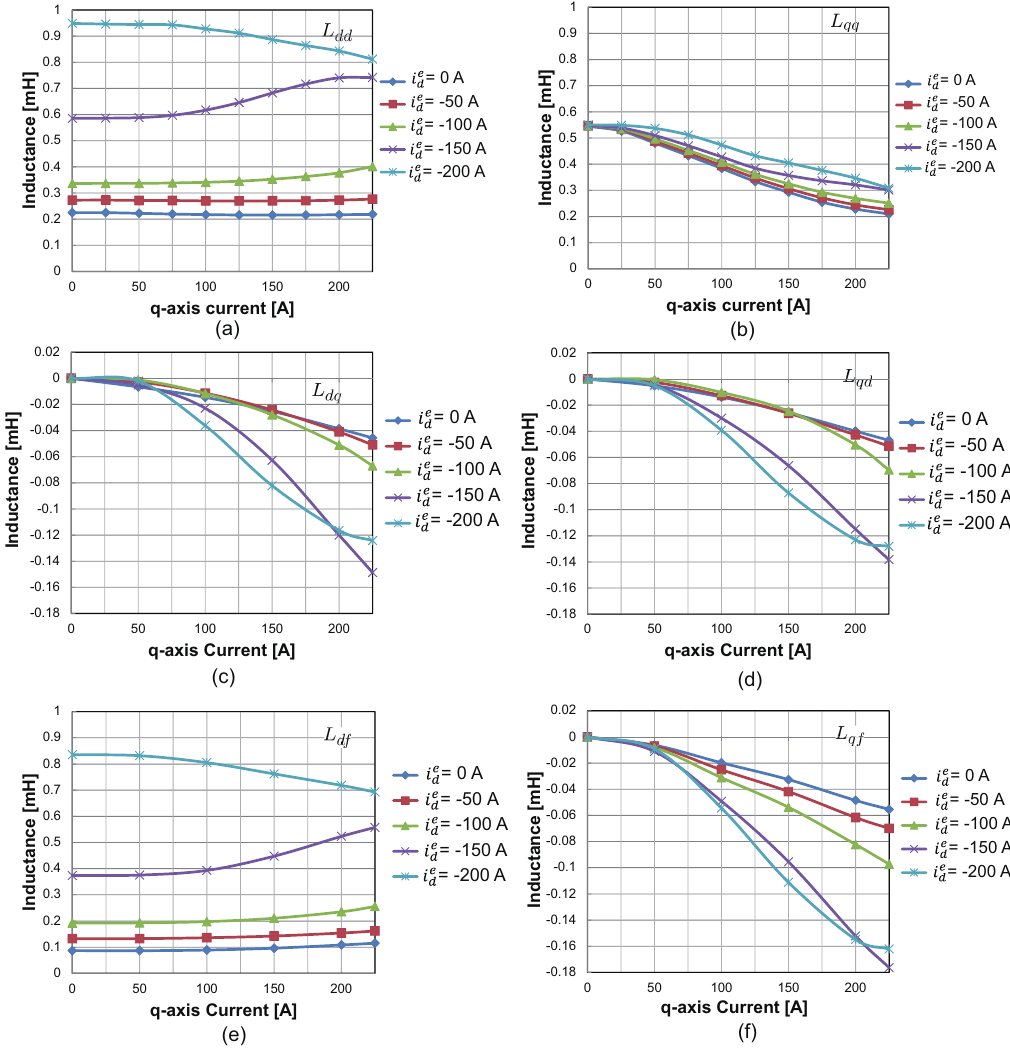
Figure 6. Finite-element method (FEM) data for the self and mutual incremental inductances: ( a ) d -axis self-inductance L dd ; ( b ) q -axis self-inductance L qq ; ( c ) d -axis and q -axis cross-coupling inductance L dq ; ( d ) q -axis and d -axis cross-coupling inductance L qd ; ( e ) d -axis and field coil mutual inductance L df ; and ( f ) q -axis and field coil cross-coupling inductance L qf